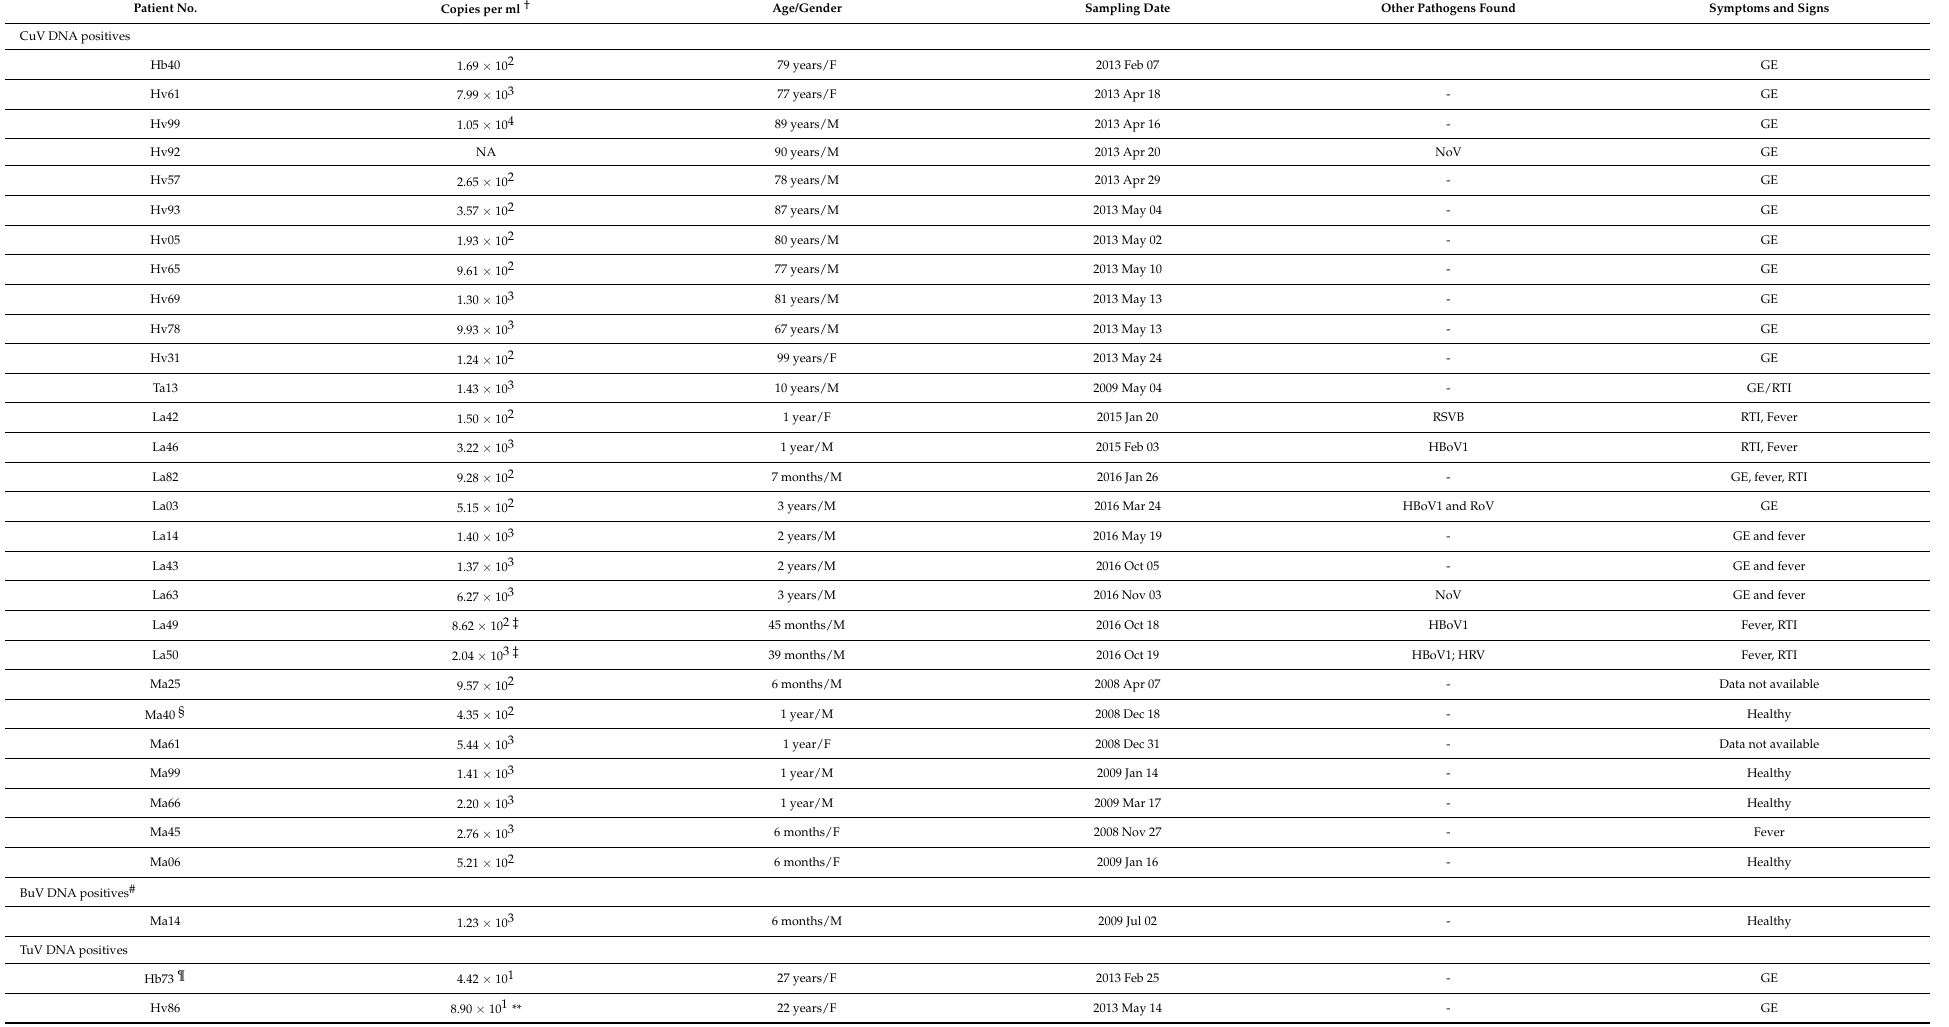
Table 3. CuV, BuV and TuV DNA-positive samples from children and adults in the current study.